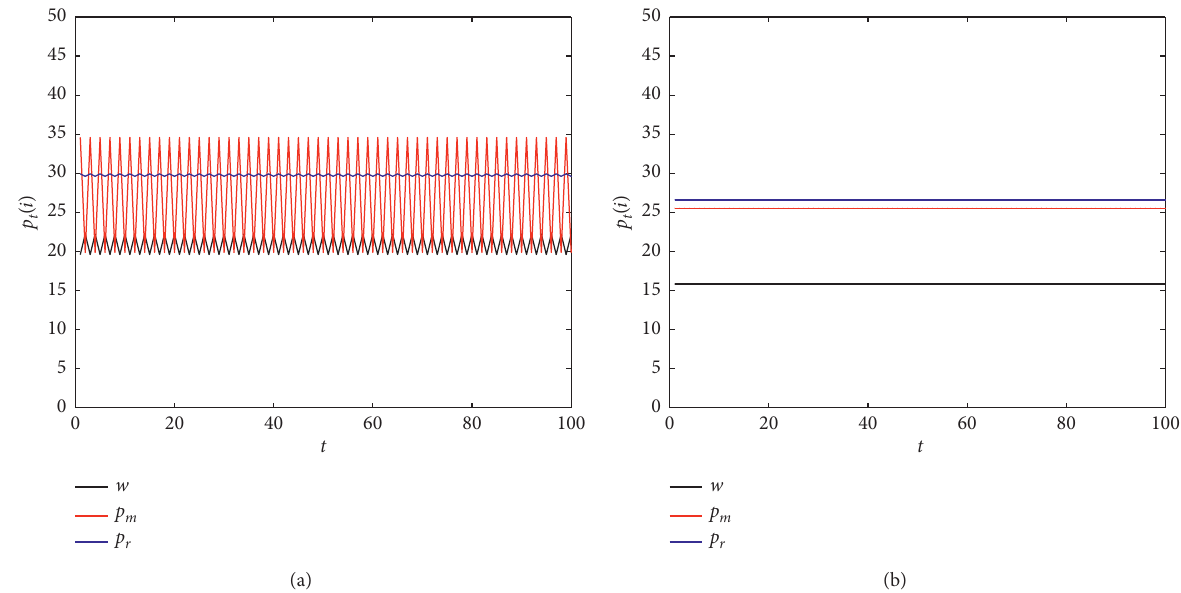
� 0 . 02 and α � 0 . 04. 1 2